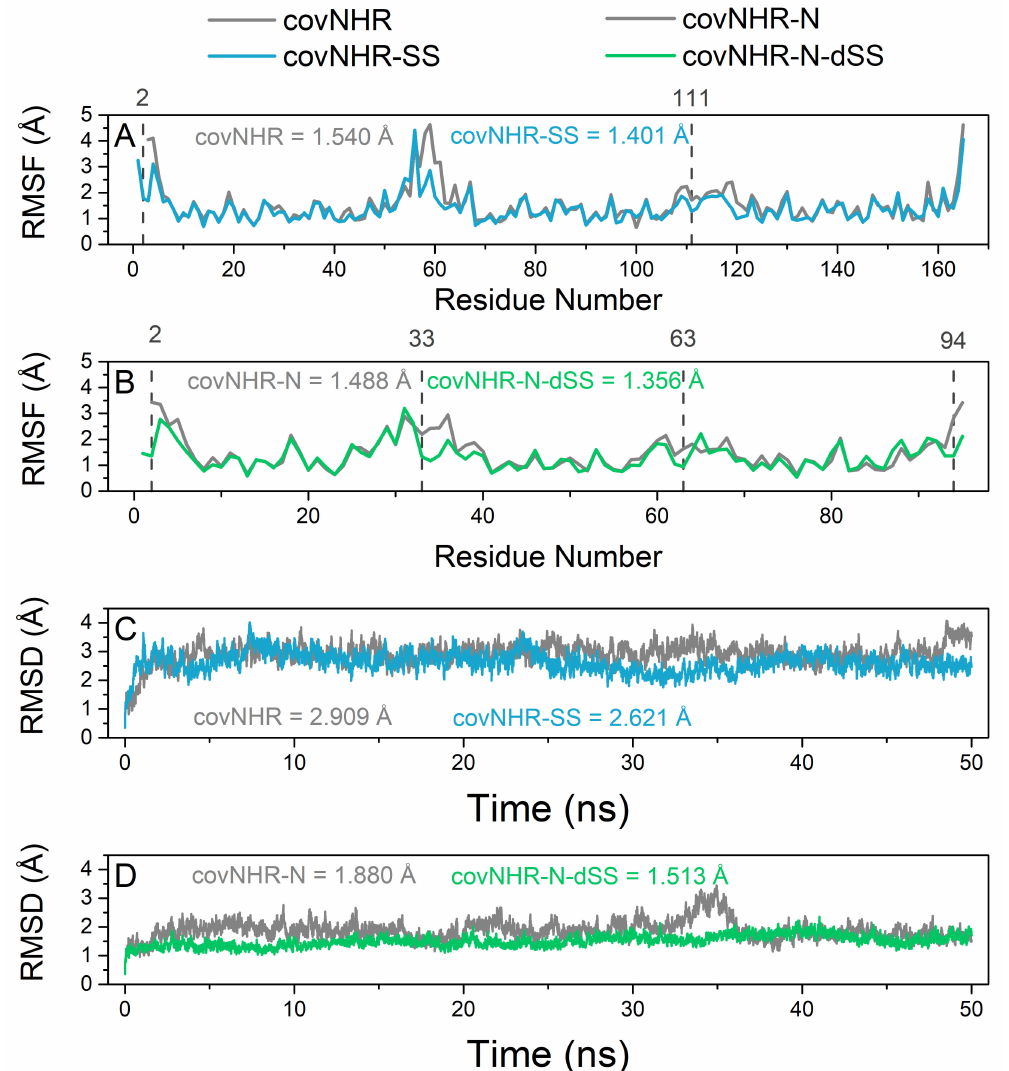
Figure 2. Molecular dynamics simulations analysis of the two miniproteins: covNHR-SS (blue) and covNHR-N-dSS (green) compared with their parent molecule covNHR and covNHR-N, respectively (grey). ( A ) Root mean square fluctuation (RMSF) per residue for covNHR and covNHR-SS. ( B ) RMSF per residue for covNHR-N and covNHR-N-dSS. ( C ) Evolution of mean backbone root mean square deviation (RMSD) for covNHR and covNHR-SS. ( D ) Evolution of RMSD for covNHR-N and covNHR- N-dSS. The locations of residues forming the disulfide bonds are highlighted with grey dashed lines and with their residue number shown above in A and B. Mean values for the parameters throughout the entire simulation time are also displayed in each panel with the same color code used